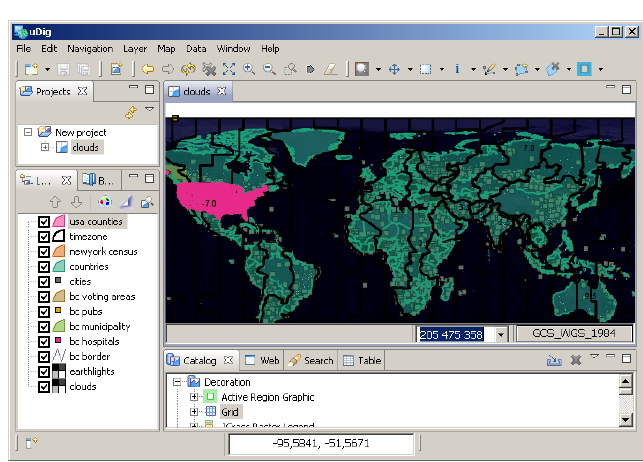
Fig. 1. The user interface of uDig with sample